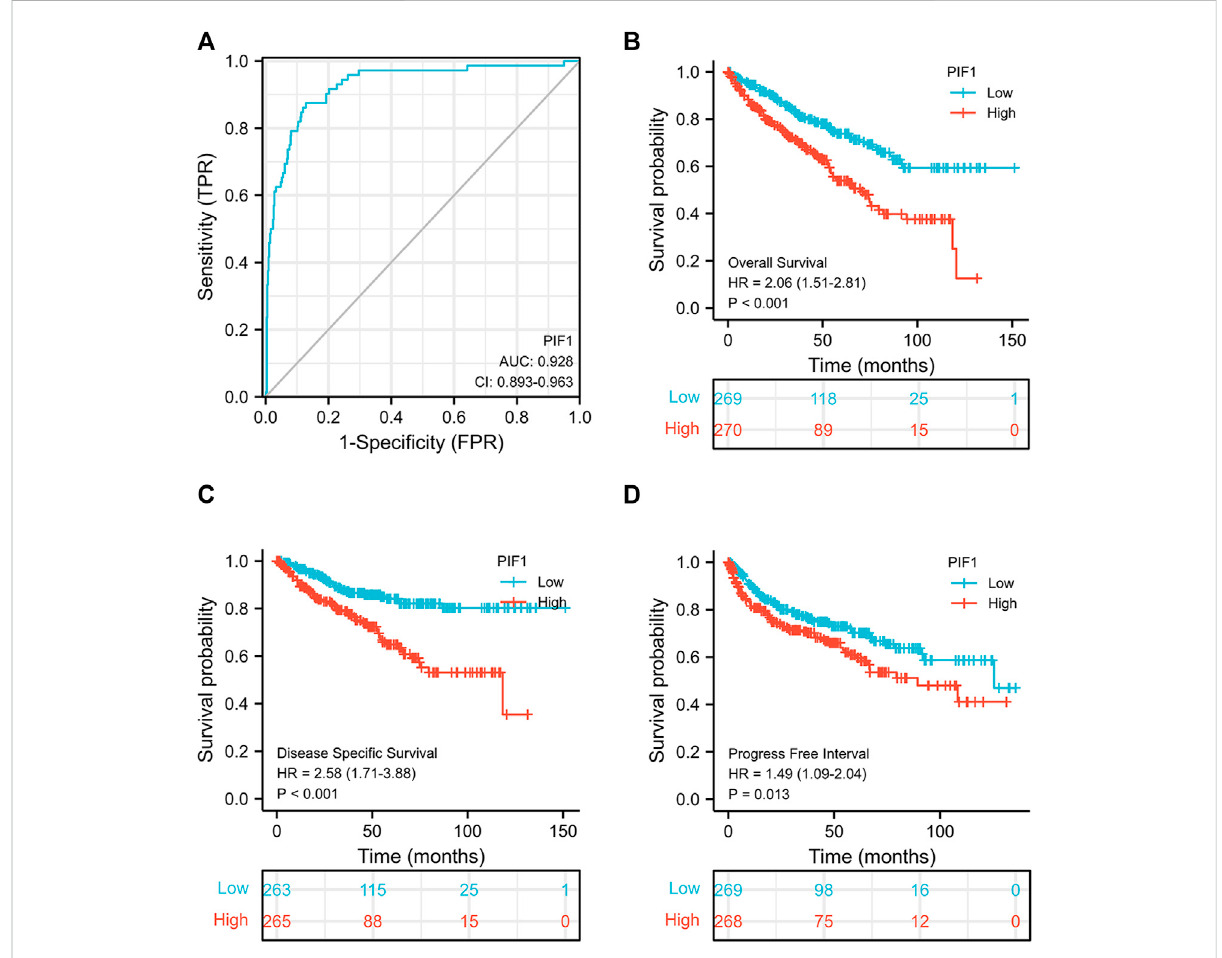
FIGURE 4 ROC and Kaplan ‒ Meier curves for PIF1. (A) ROC curve showed that PIF1 had an AUC value of 0.928 to discriminate ccRCC tissues from healthy controls. (B – D) Kaplan ‒ MeiersurvivalcurvesindicatedthatccRCCpatientswithhighPIF1mRNAexpressionhadashorterOS,DSSandPFIthanthose with low PIF1 mRNA expression. OS: overall survival; DSS: disease-speci fi c disease; PFI: progression-free